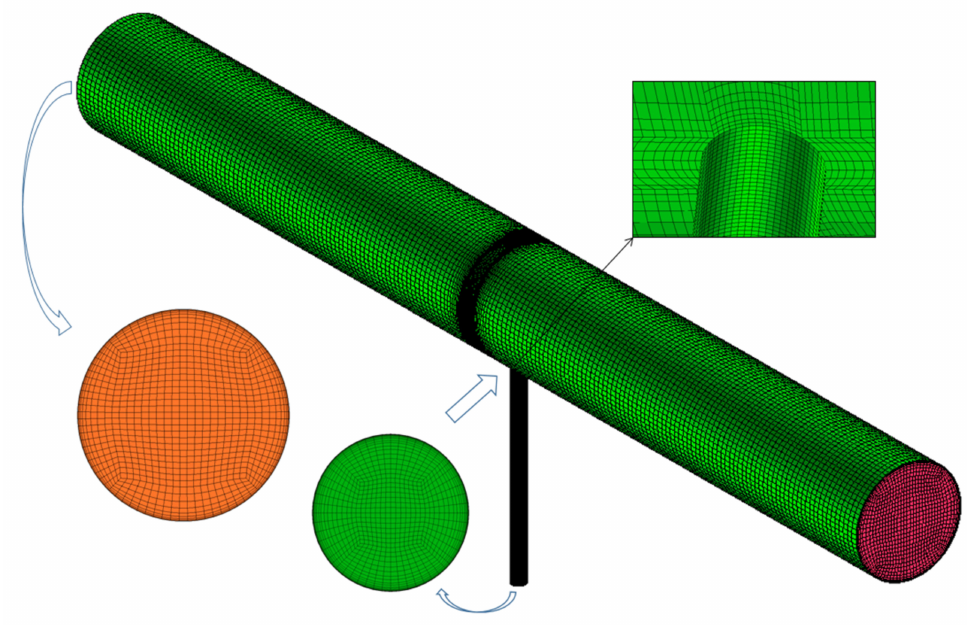
Figure 4. Grid partition of case